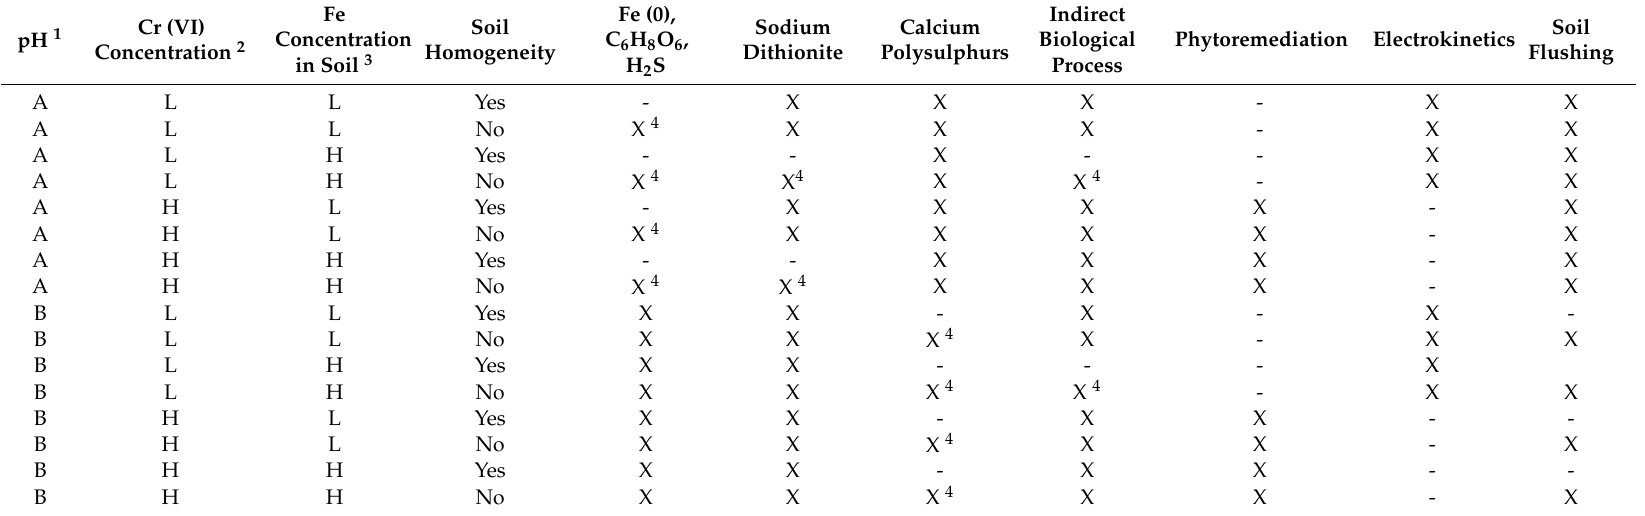
Table 3. Low applicability/inapplicability (shown by an “X”) of the innovative technologies examined, according to the factors in Table 2; the zone of potential application shown in Table 1 is